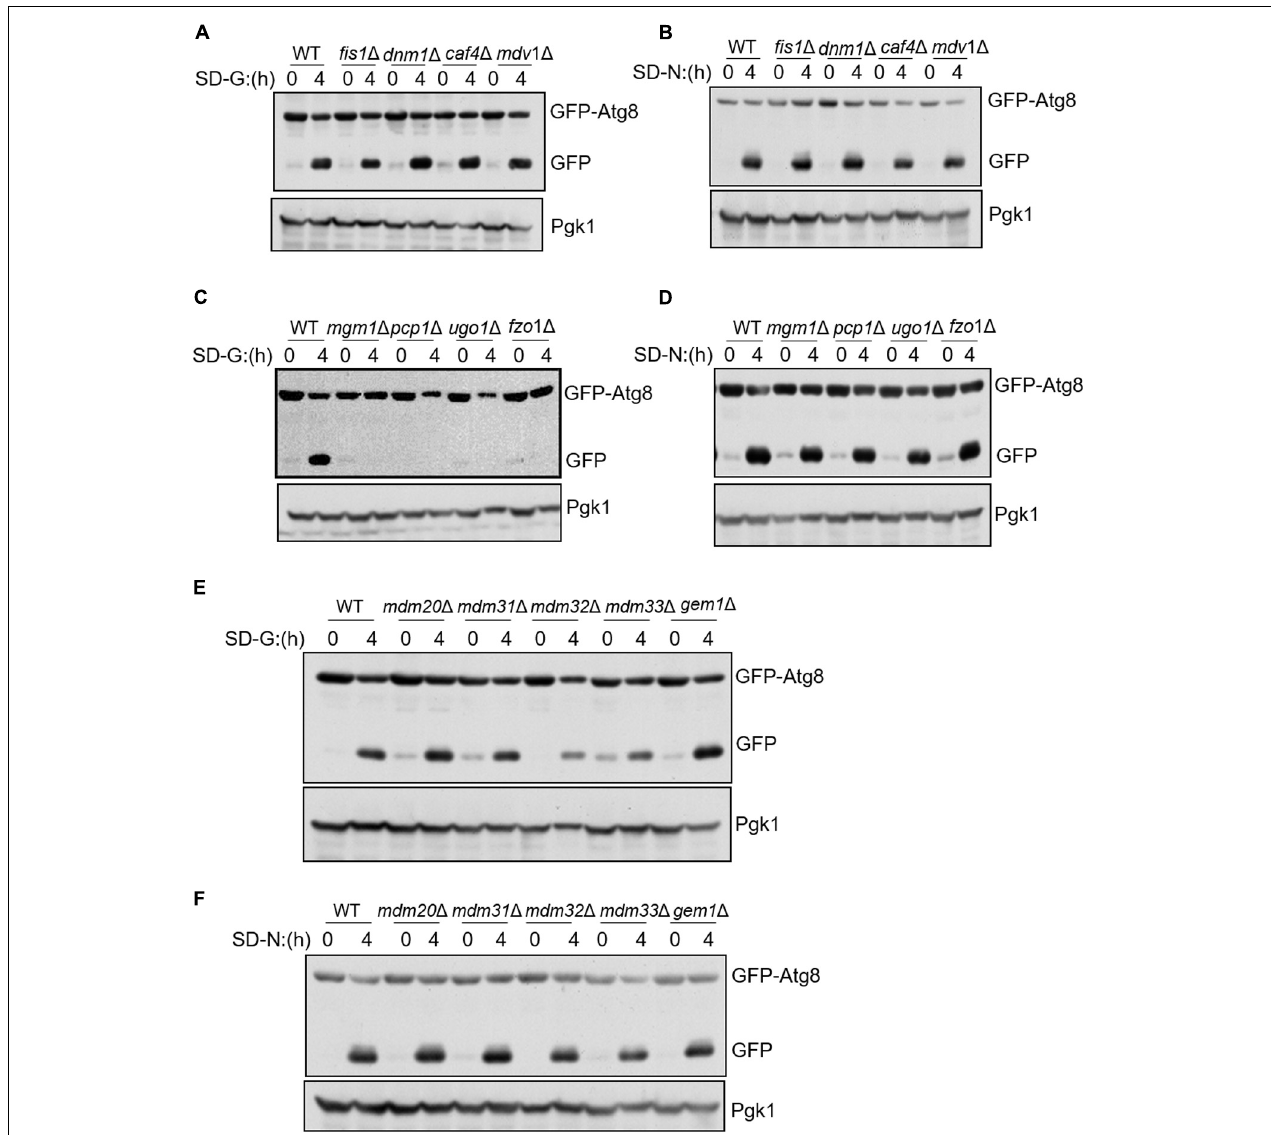
FIGURE 1 | Mitochondrial fusion machinery is specifically involved in glucose starvation-induced autophagy. GFP-Atg8 plasmids were expressed in yeast strains accordingly listed from (A–F) . Yeast cells were grown to the log-growth phase, then subjected to glucose starvation (SD-G) or nitrogen starvation (SD-N) for 4 h. Autophagic activity was detected by western blot using anti-GFP